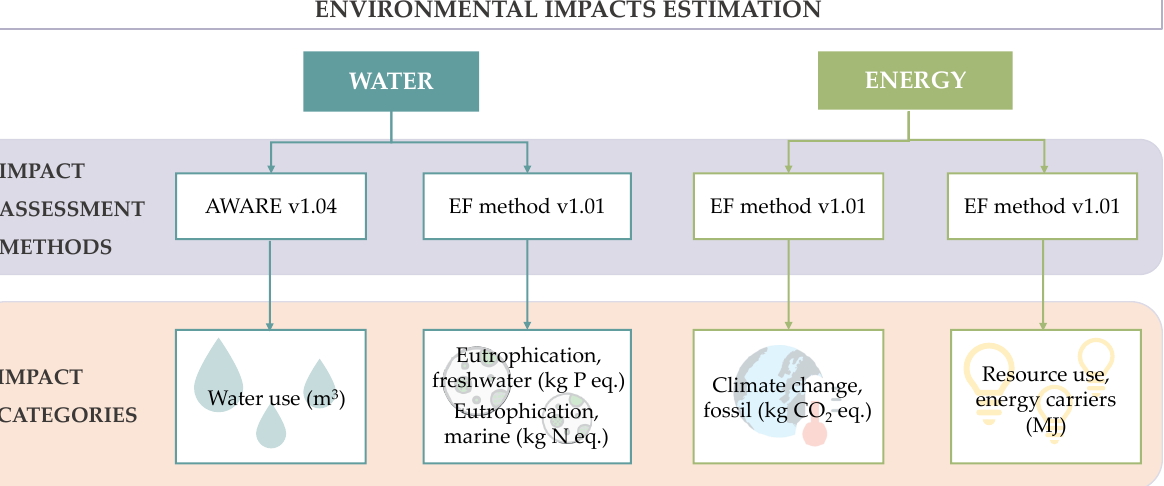
Figure 3 . Impact assessment methods and indicators used for the calculation of environmental footprints.